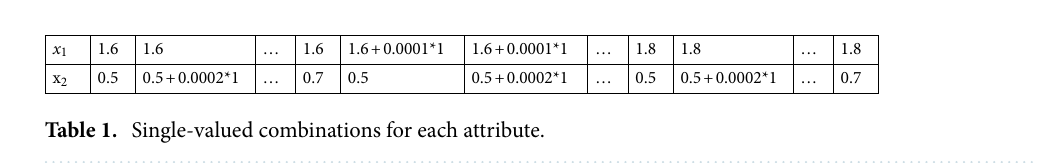
Figure 1. Calculation process of the nonlinear optimization algorithm.